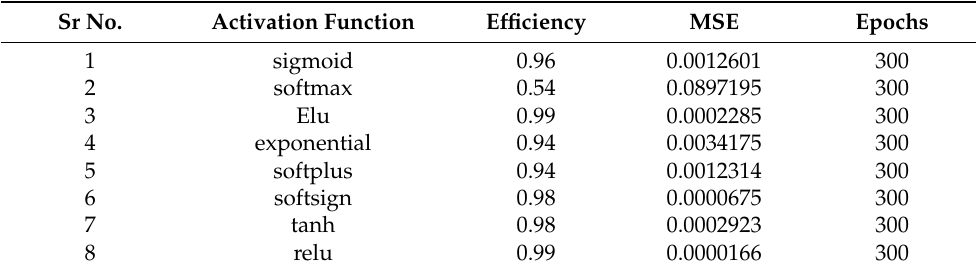
Table 3. Comparative analysis of activation functions. Sr